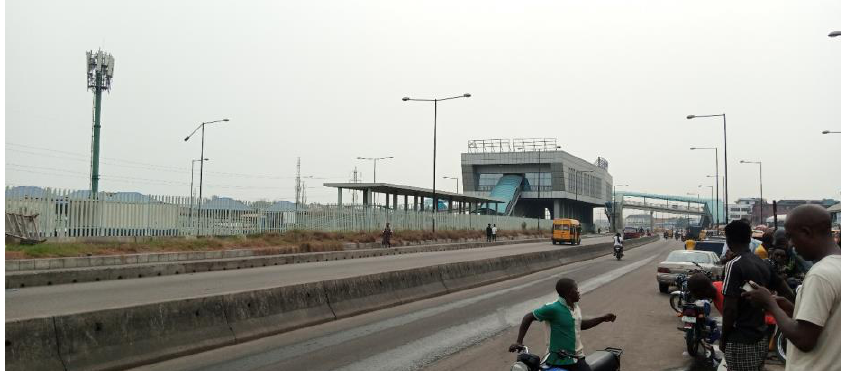
Fig. 9. Expansion of the Lagos-Badagry Expressway with embedded light rail at